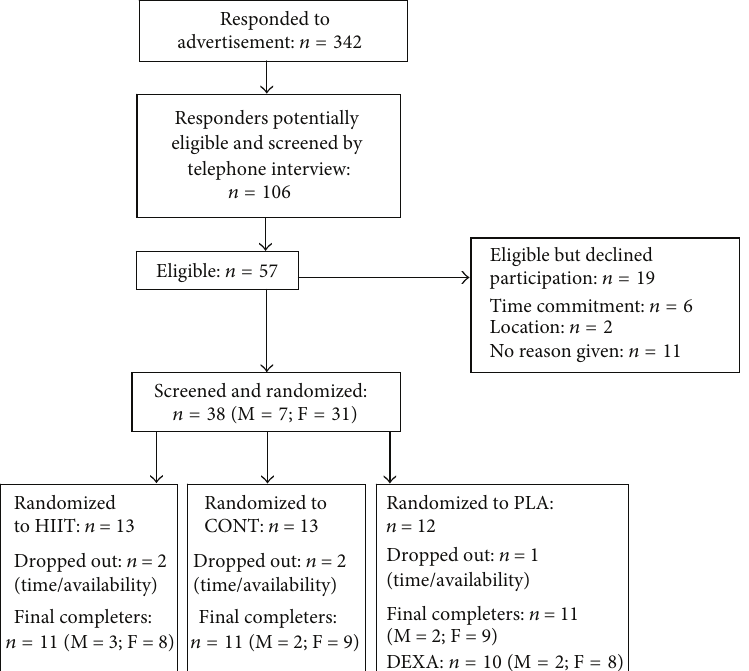
Figure 1: Flowchart showing the study process. M: male, F: female, HIIT: high intensity interval training, CONT: continuous aerobic exercise, PLA: placebo control